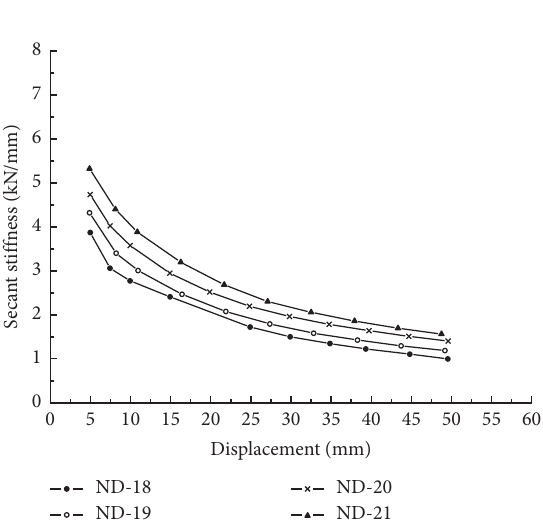
Figure 26: Stiffness curves of slit width